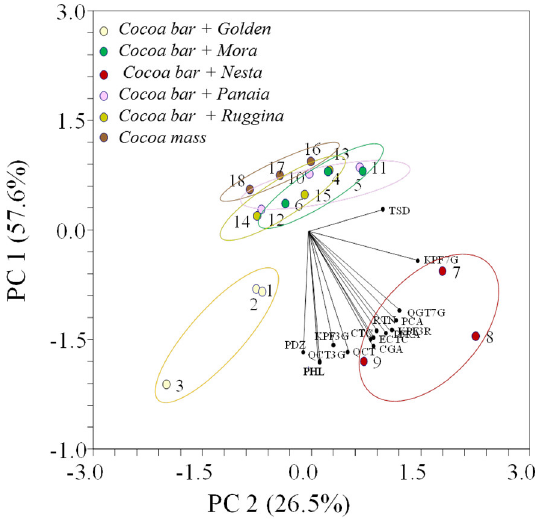
Figure 3. Biplot of PC1 vs. PC2, showing the loadings of the scores and the variables of cocoa mass and the cocoa bars with apples. Color dots with the number representing different cultivars analysed in triplicate. Table 3. Loadings of each attribute on the two principal components calculated using the data produced by the UHPLC-MS/MS on six cocoa bars.